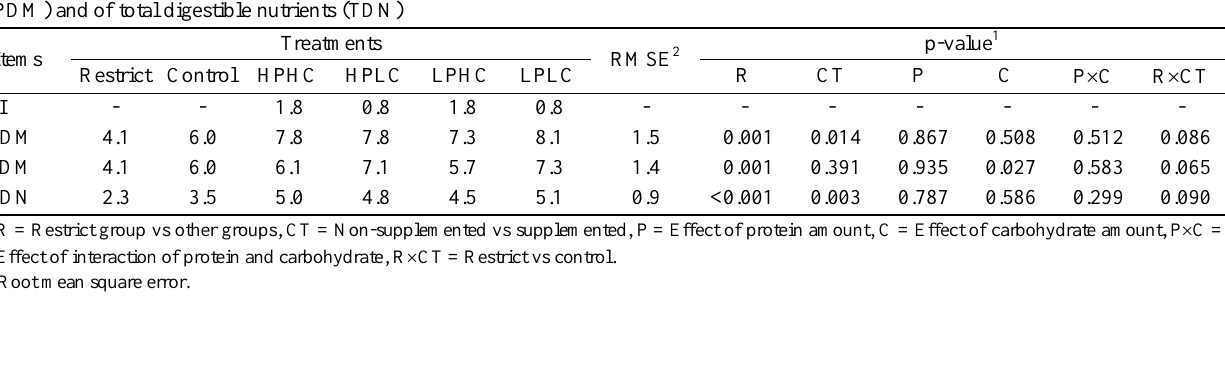
Table 2. Distribution of coefficients for orthogonal contrasts used in the decomposition of the sum of squares Contrasts 1